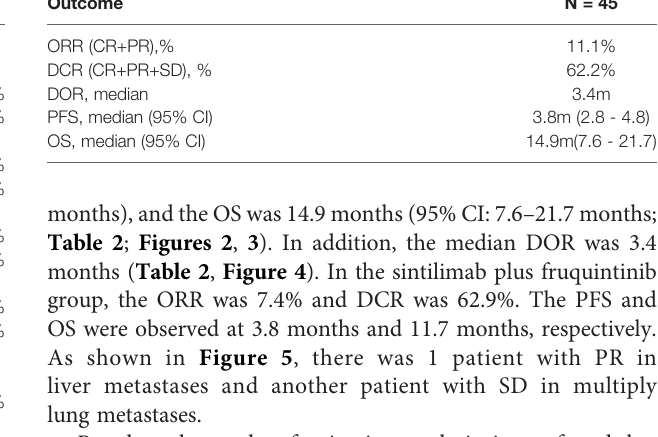
TABLE 1 | Baseline Characteristics of patients (n=45). Characteristics